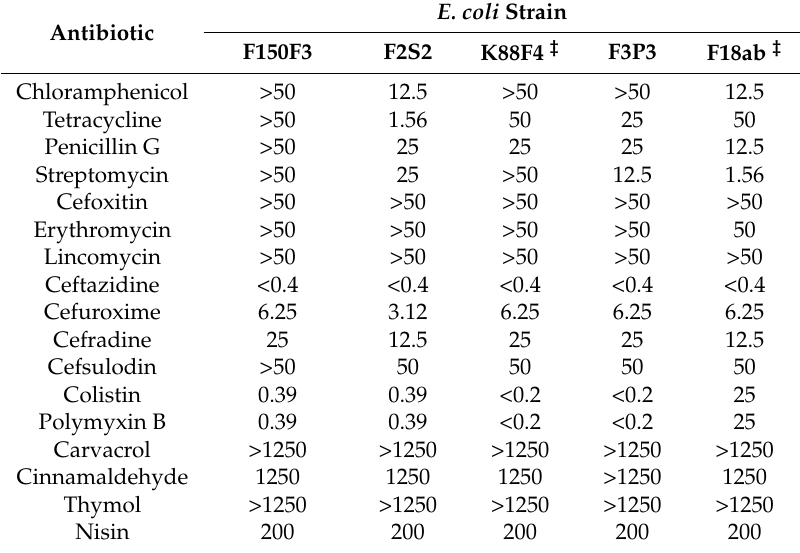
Table 1. Minimum inhibitory concentration determinations of nisin A, and the essential oils thymol, carvacrol and trans-cinnamaldehyde against E. coli strains of swine origin. ‡ denotes enterotoxigenic Escherichia coli (ETEC) strains. Results are expressed as the mean of triplicate assays.